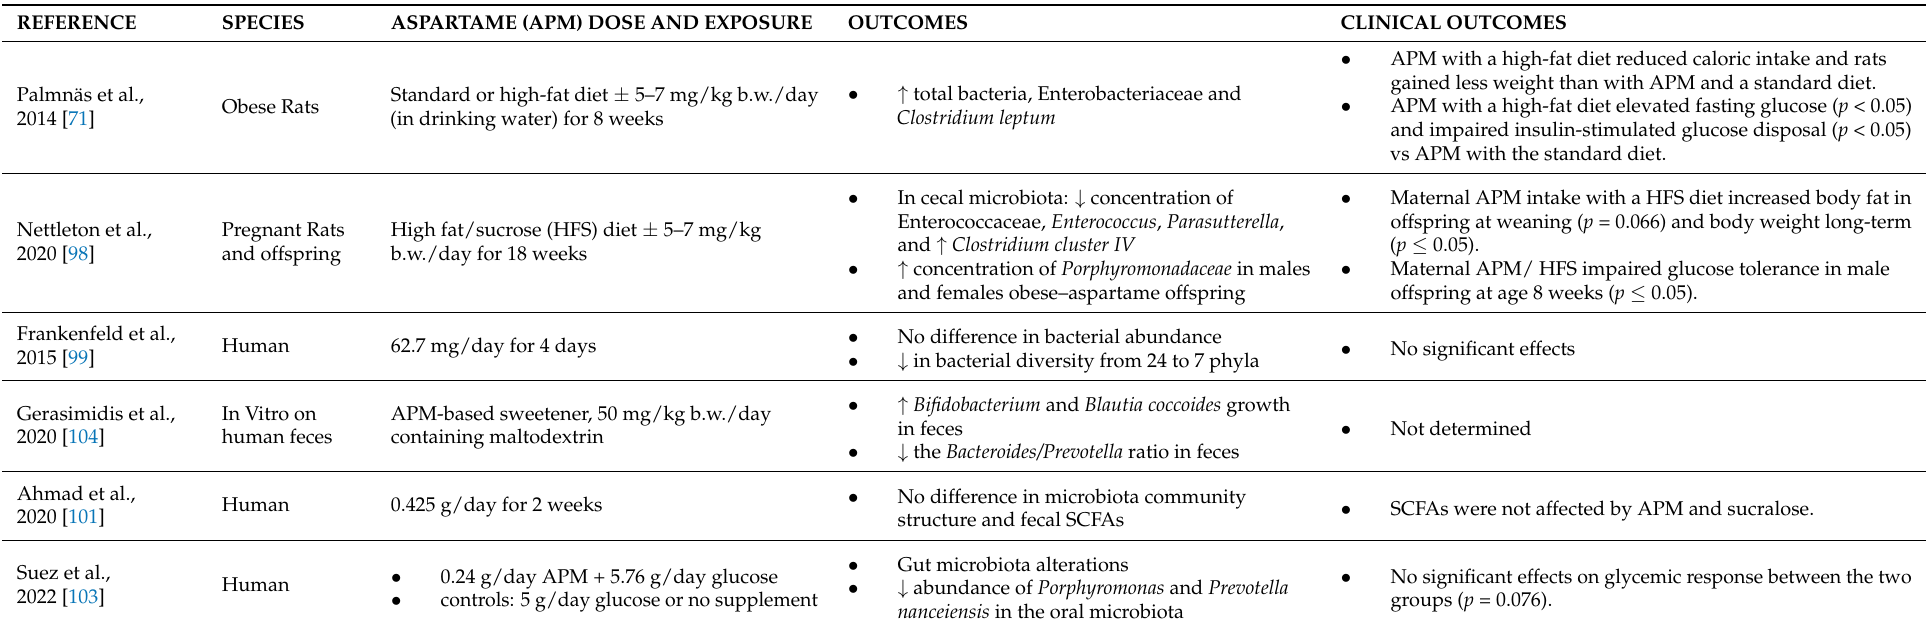
Table 2. Studies evaluating the effect of aspartame on the gut